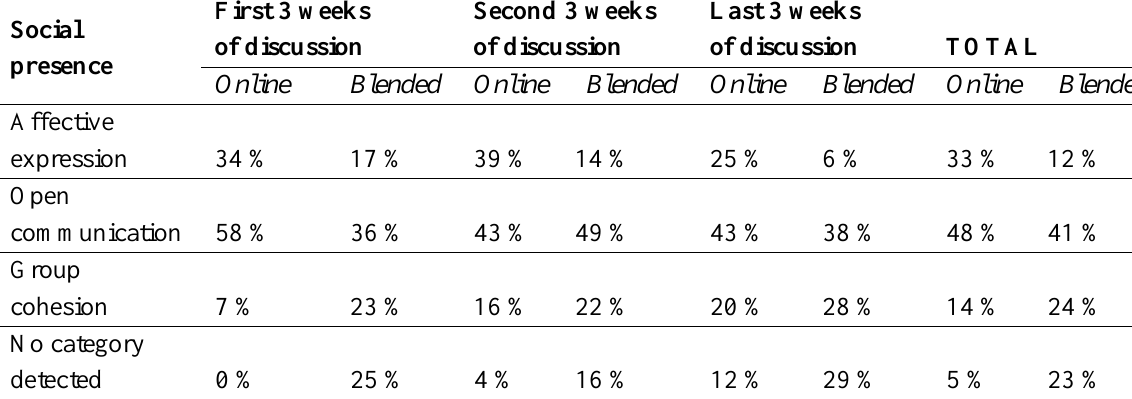
Comparison of Coding Results for Social Presence between